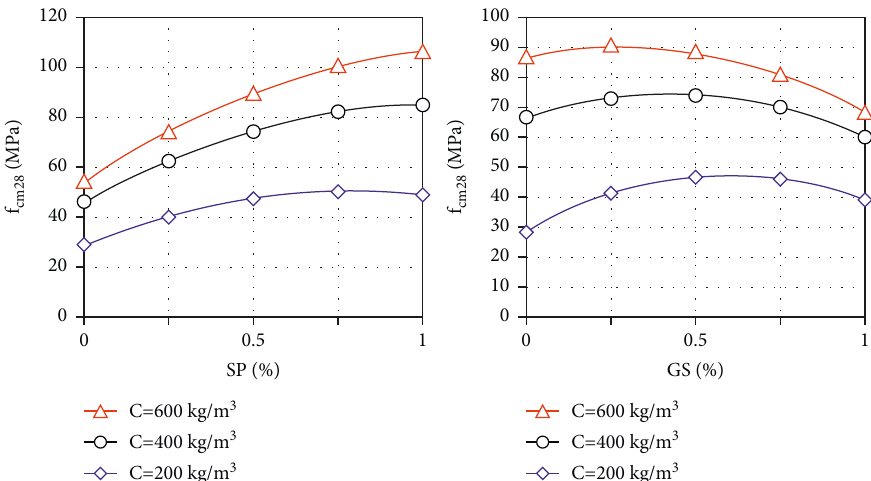
Figure 6: The influence of SP and blast furnace slag contents at different cement consumption values on SCC compressive strength at 28 days (the third factor in graphs is at the average level according to Table 4).